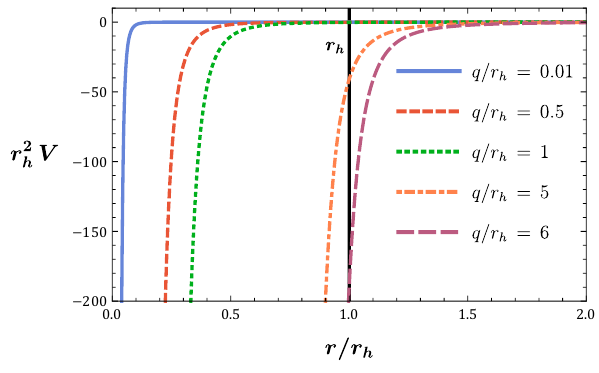
Figure 5. The potential r 2 dimensionless parameter q/r